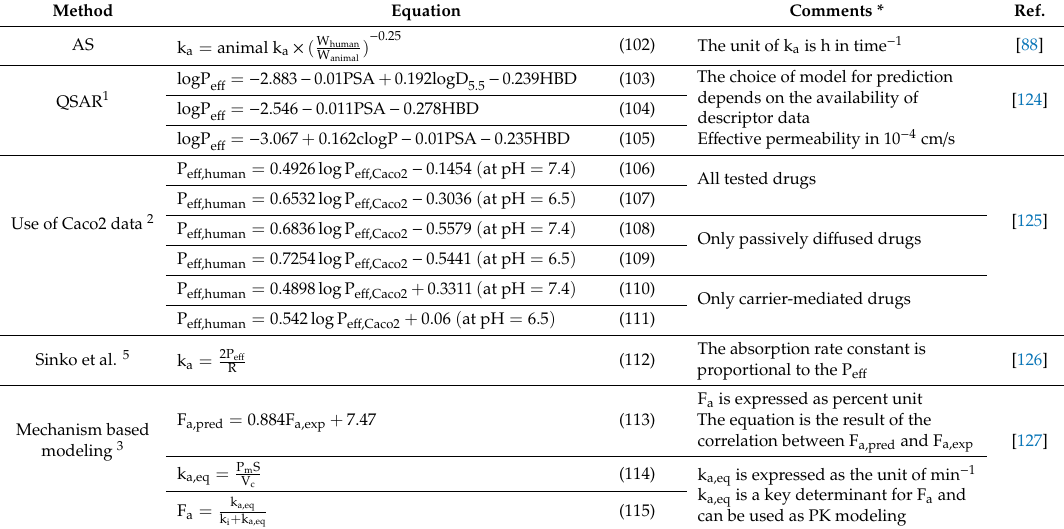
Table 5. Methods for prediction of absorption